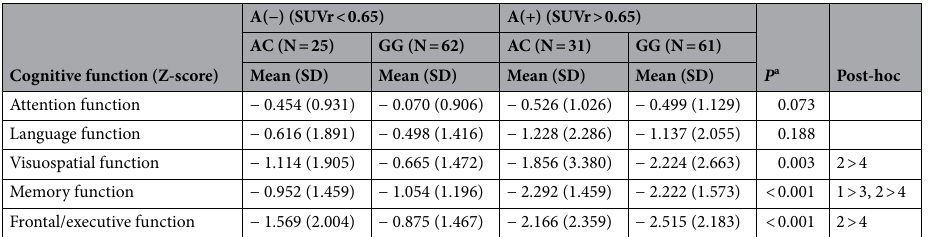
Table 2. Cognitive function of study participants grouped according to the SUVr of amyloid PET and the presence of rs671 A allele (N = 179). AC, A-carrier; PET, positron emission tomography SD, standard deviation; SUVr, standardized uptake value ratio. All values are z-score results. a ANOVA test was conducted for continuous variables.